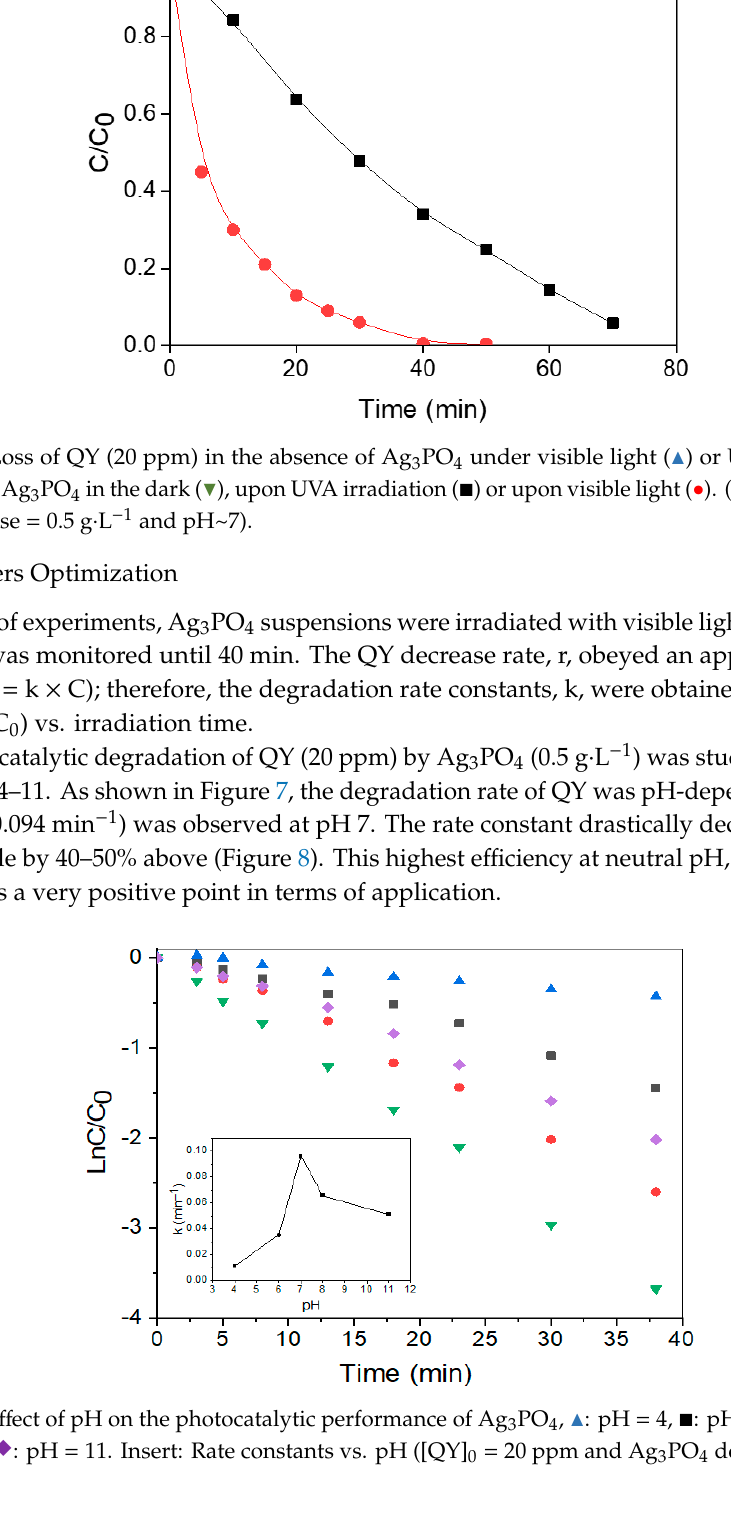
Figure 5. Direct optical transition of Ag 3 PO 4 .